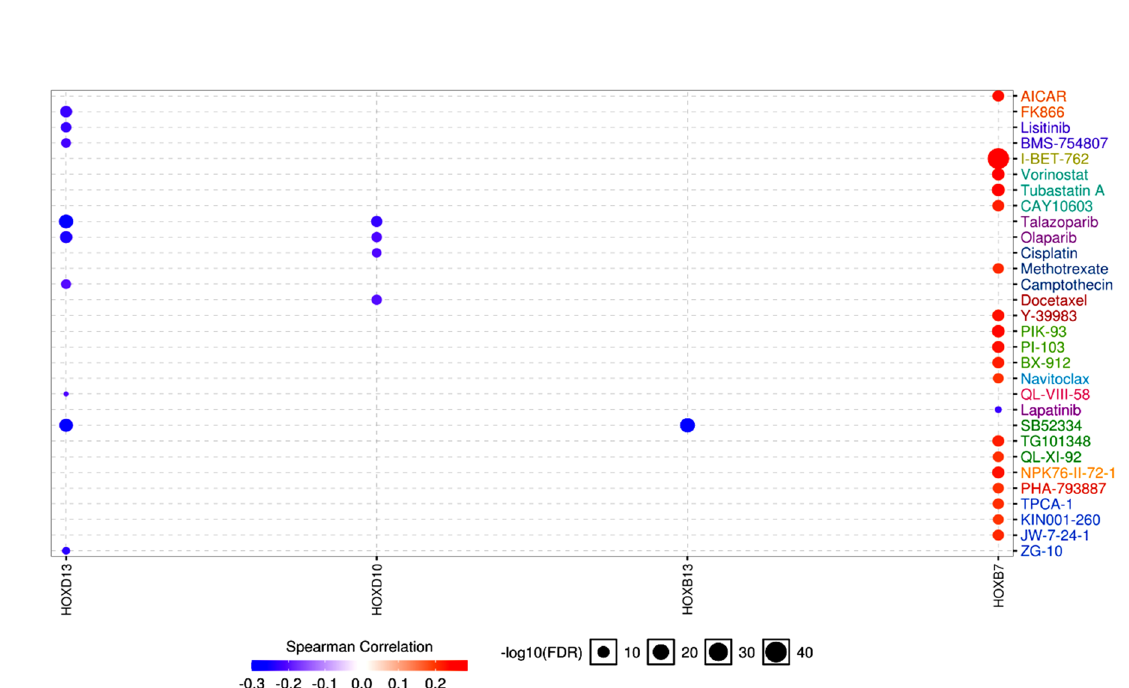
Figure 5. HOX genes and drug sensitivity: A bubble plot showing the interaction between the DEHGs and the known and novel therapeutic